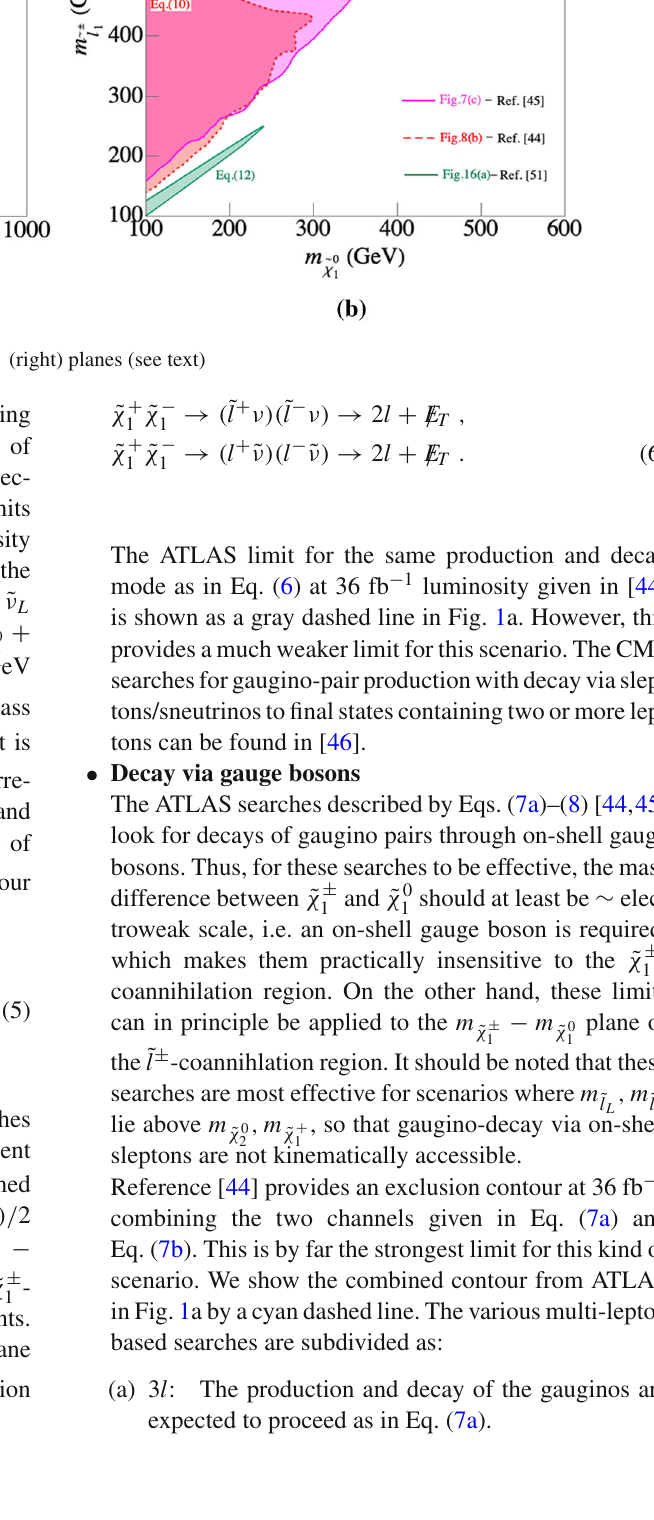
Fig. 1 Latest LHC constraints in the m ˜ χ 0